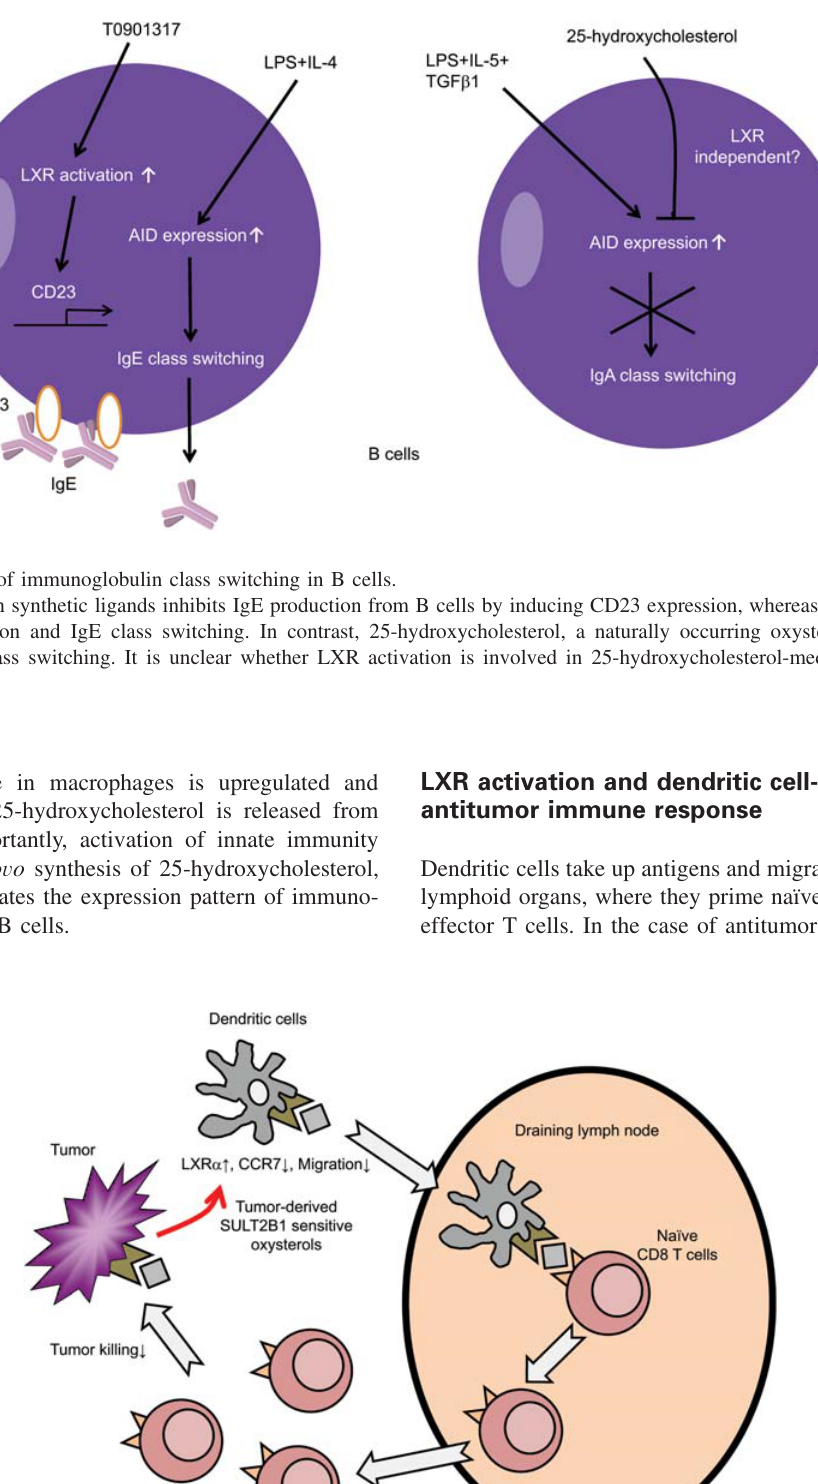
Figure 4 Tumor cells escape from antitumor immune responses by activating LXR signaling. Tumor cells produce oxysterols that are sensitive to SULT2B1. These oxysterols activate LXR a in dendritic cells. CCR7 expression on dendritic cells is subsequently reduced in an LXR a -dependent manner. Dendritic cells lacking CCR7 fail to migrate into lymphoid organs such as draining lymph nodes, resulting in abrogation of naı¨ve CD8 T cell priming and effector cell expansion.